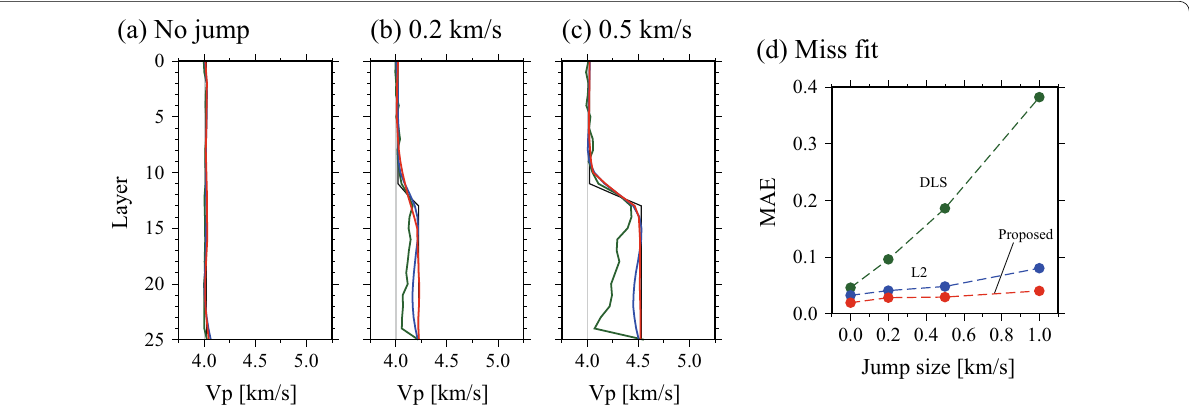
Fig. 6 Recovery of the estimated average velocities by changing the size of the velocity jump: a 0.0 km/s; b 0.2 km/s; and c 0.5 km/s. d MAE variations for each of the tested velocity jumps and methods (DLS, l 2 -smoothness regularization (L2), and the proposed methods). Colored lines in a – c are the same as those in Fig. 4